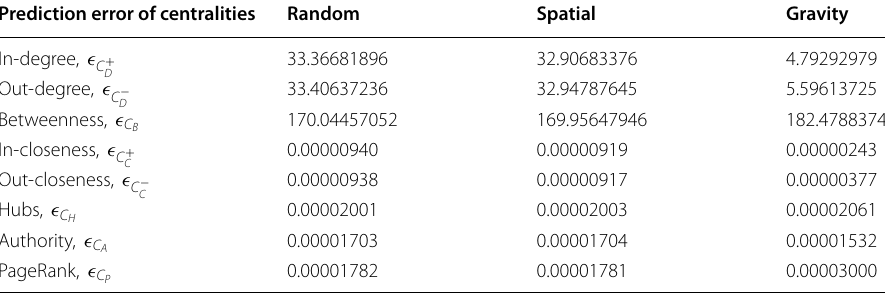
Table 4 Prediction error of centralities Prediction error of